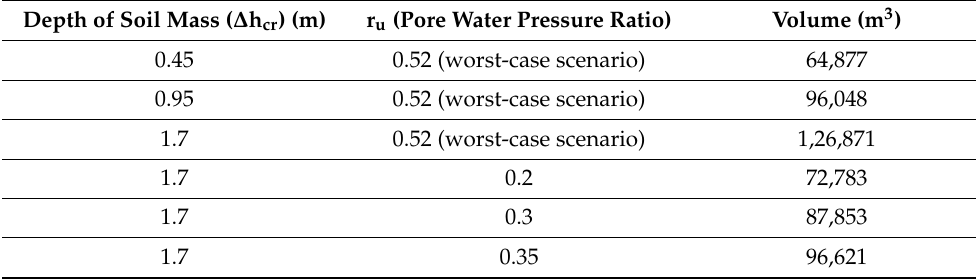
Table 3. Landslide volume for various landslide depths and pore water pressure